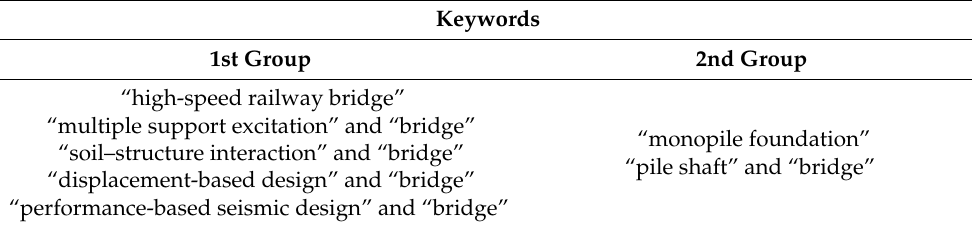
Table 4. Developed keywords for the current review.